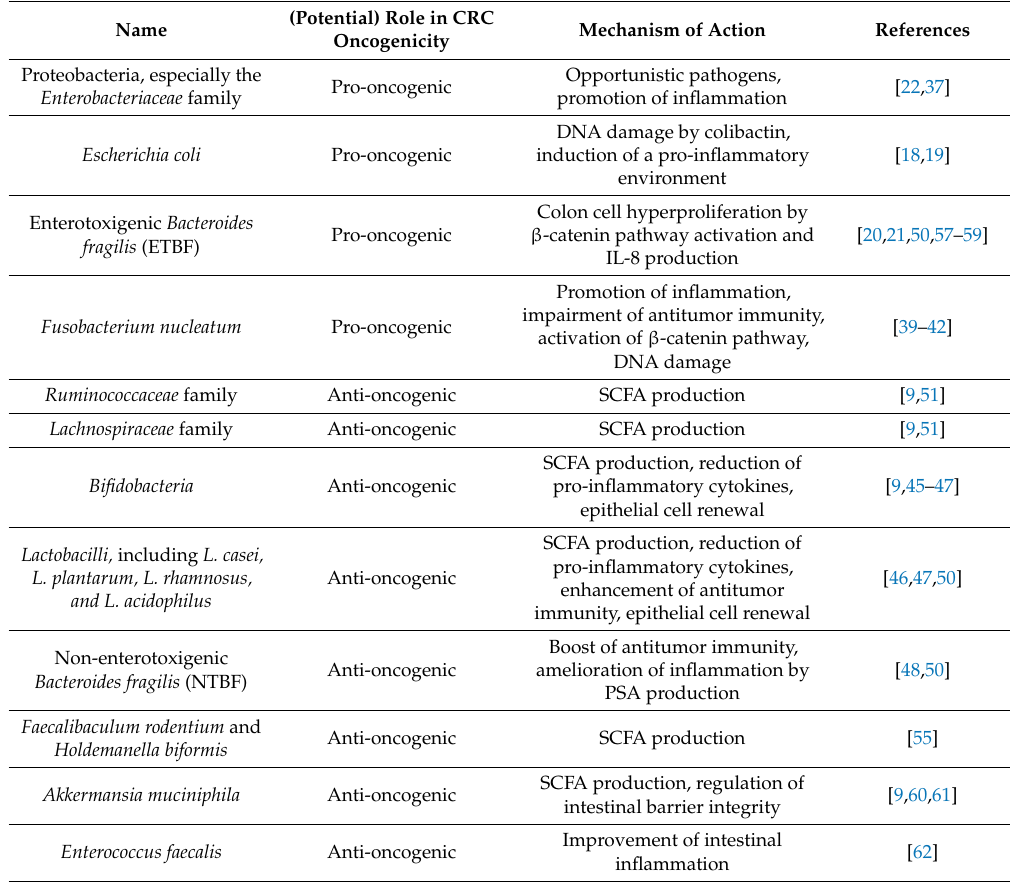
Table 1. Summary of bacteria known to be involved in colorectal cancer progression and